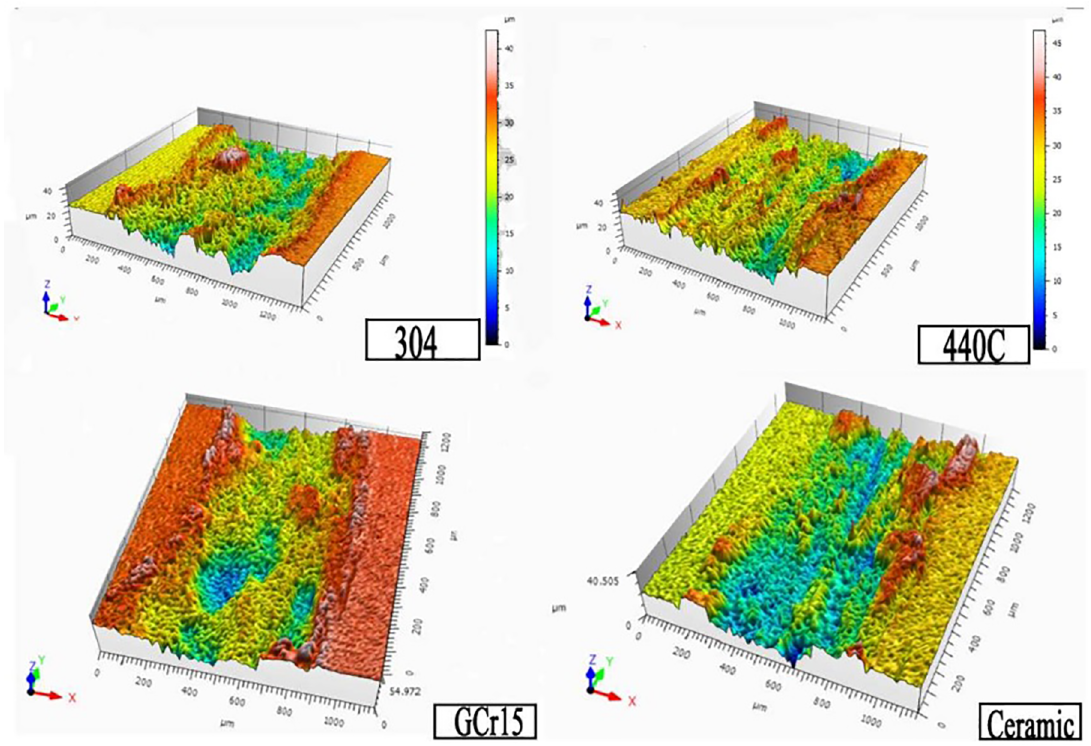
Figure 9. Three-dimensional wear morphology of four kinds of materials